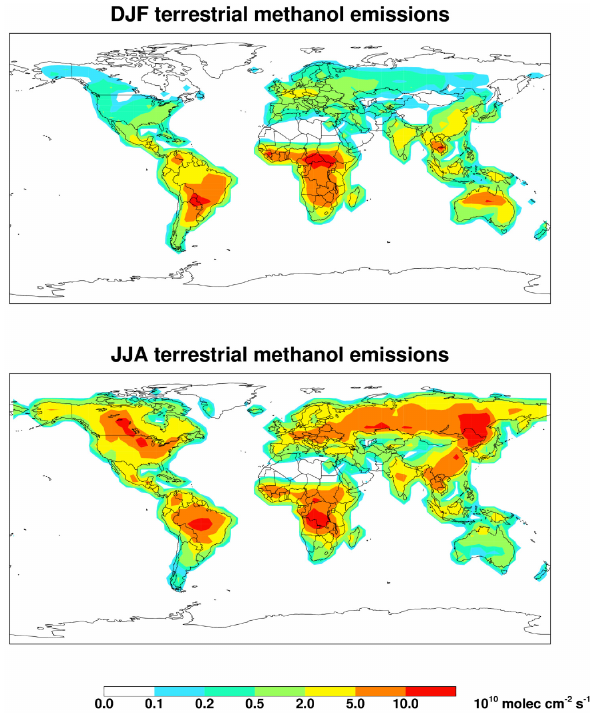
Fig. 2. December, January, February (DJF, top) and June, July, Au- gust (JJA, bottom) terrestrial methanol emissions in the GEOS- Chem a priori simulation (year 2008) from anthropogenic activities, biomass burning, biofuel burning, and terrestrial